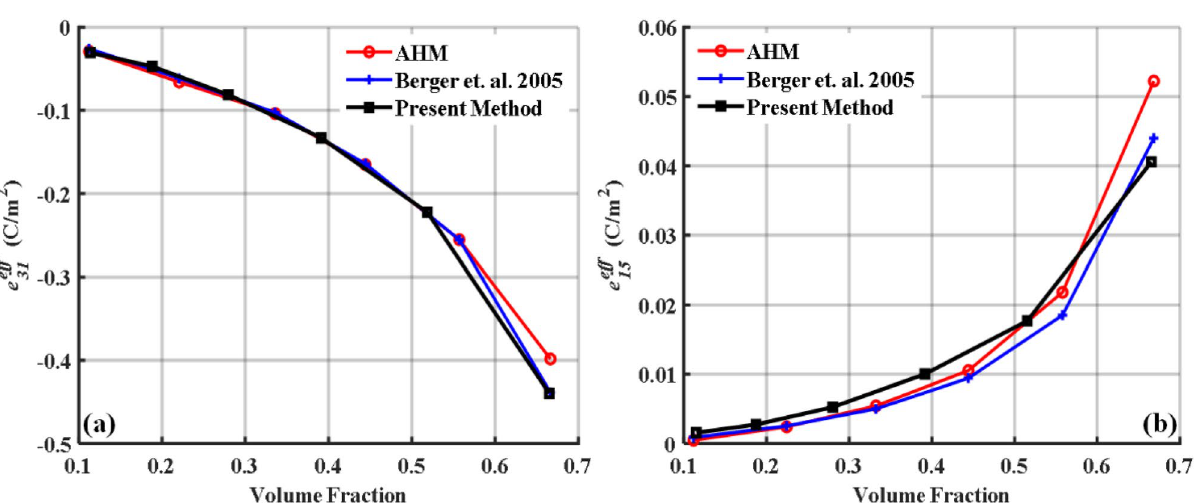
Figure 19. Validation of the present model by comparing the effective piezoelectric